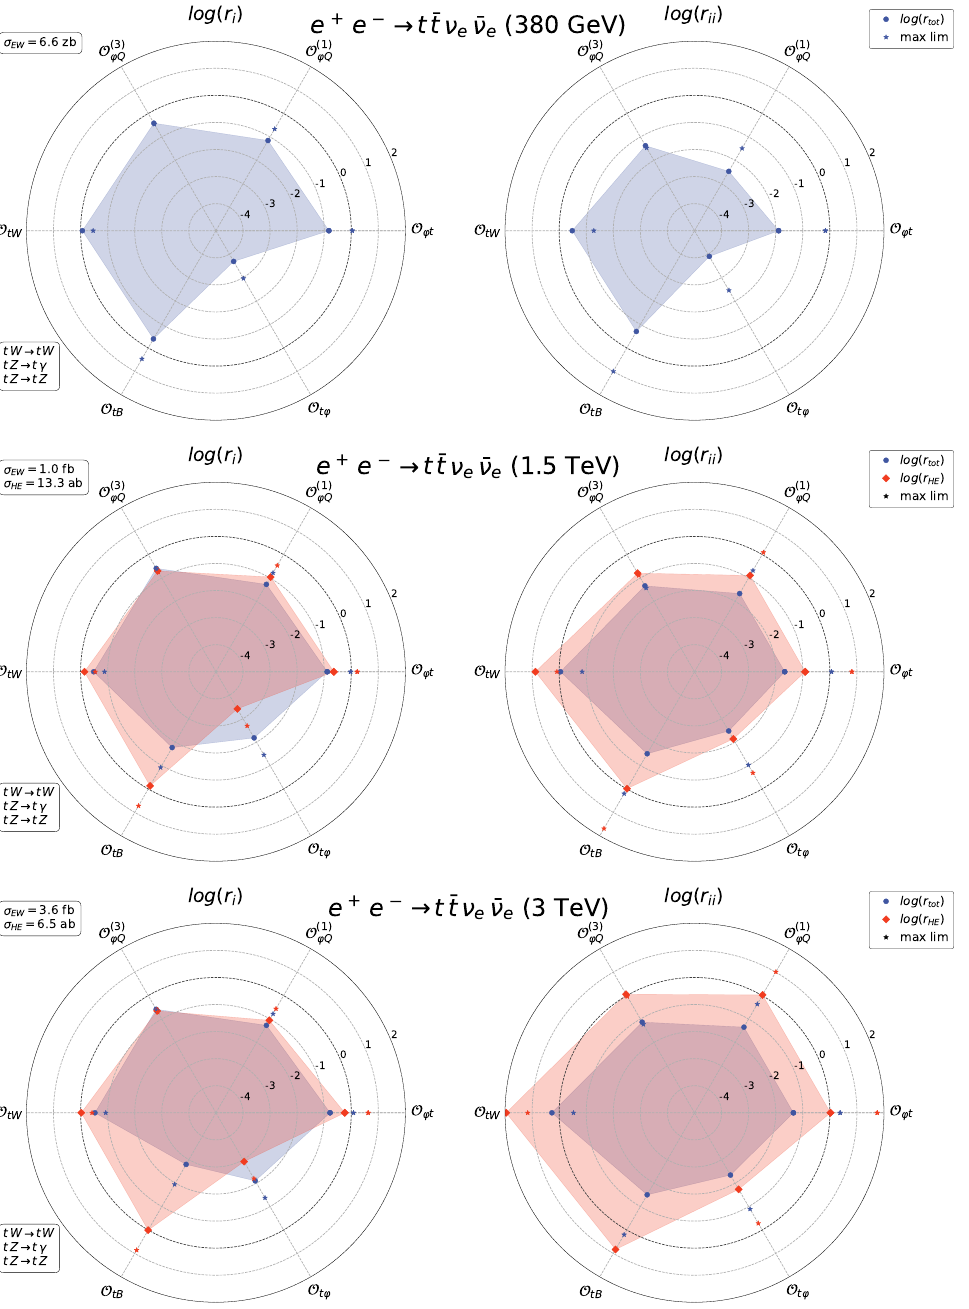
(cid:22) t (cid:23) e (cid:22) (cid:23) e process at collider centre of mass energies of 380 (cid:0) ! t